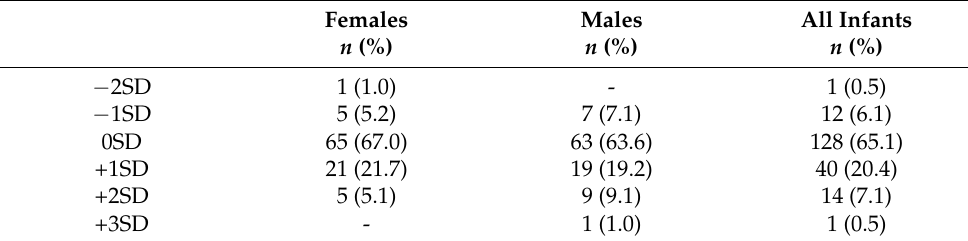
Table 3. BMI z-score distribution in all infants and by sex ( n all infants 196; n females 97; n males